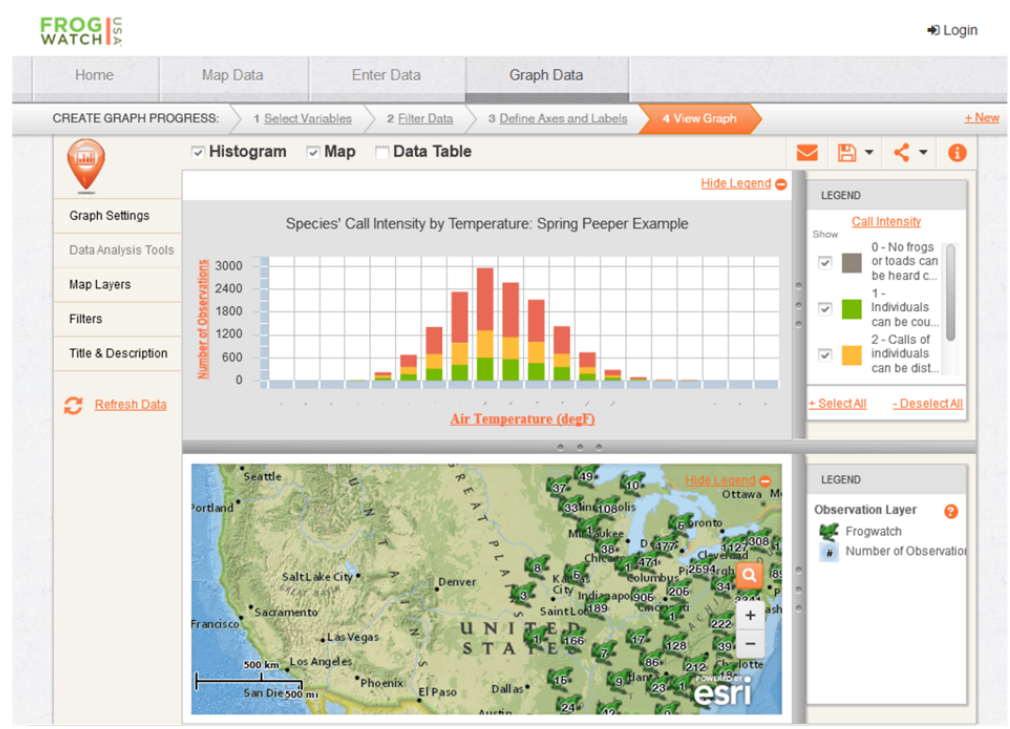
Figure 13. A view of the Fieldscope graphical analysis interface for the FrogWatch USA